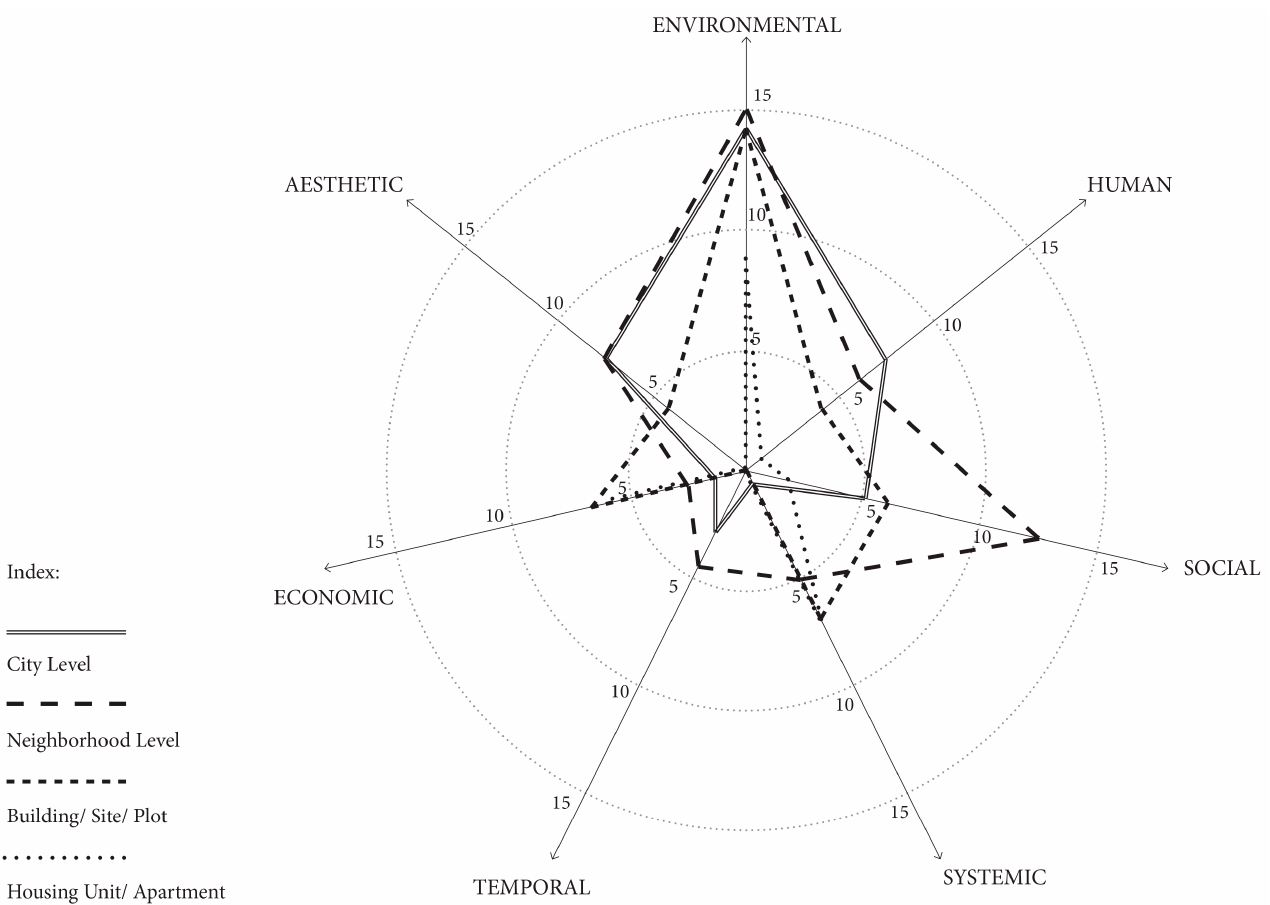
Figure 1. Multiscale distribution of recognised design values within national taxonomy.